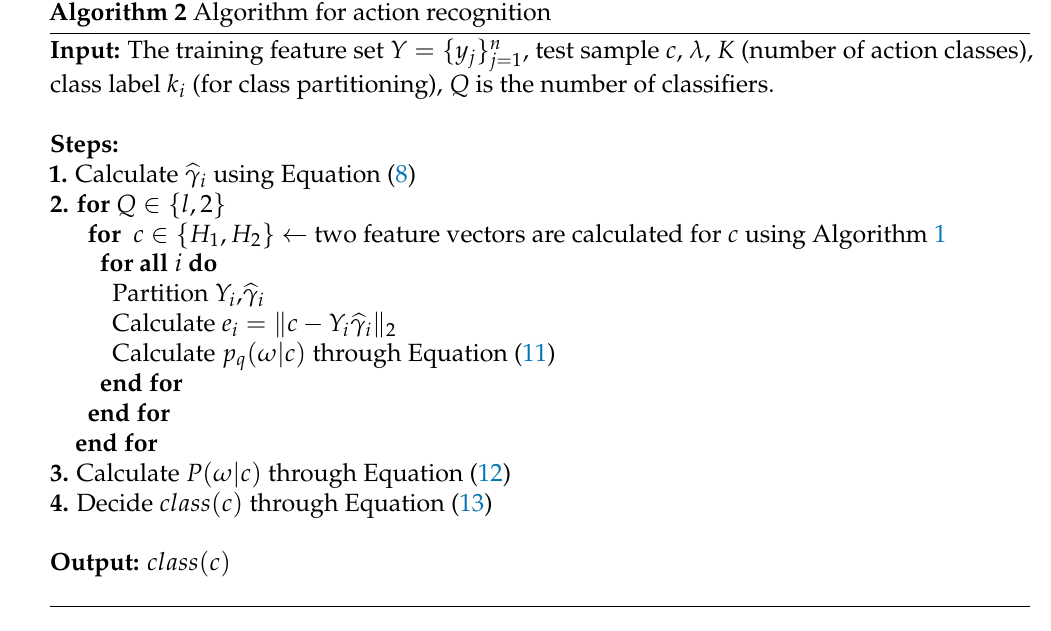
Algorithm 2 Algorithm for action